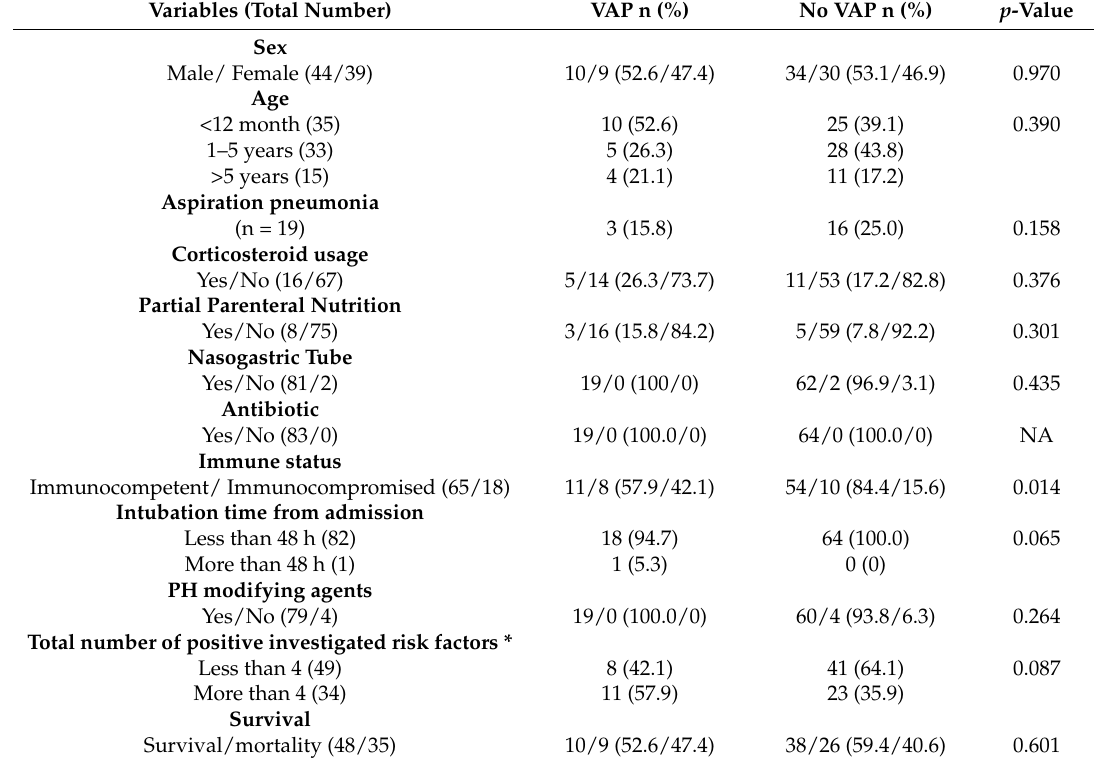
Table 1. Demographics, risk factors and mortality of children with and without ventilator-associated pneumonia (VAP) in the pediatric intensive care unit